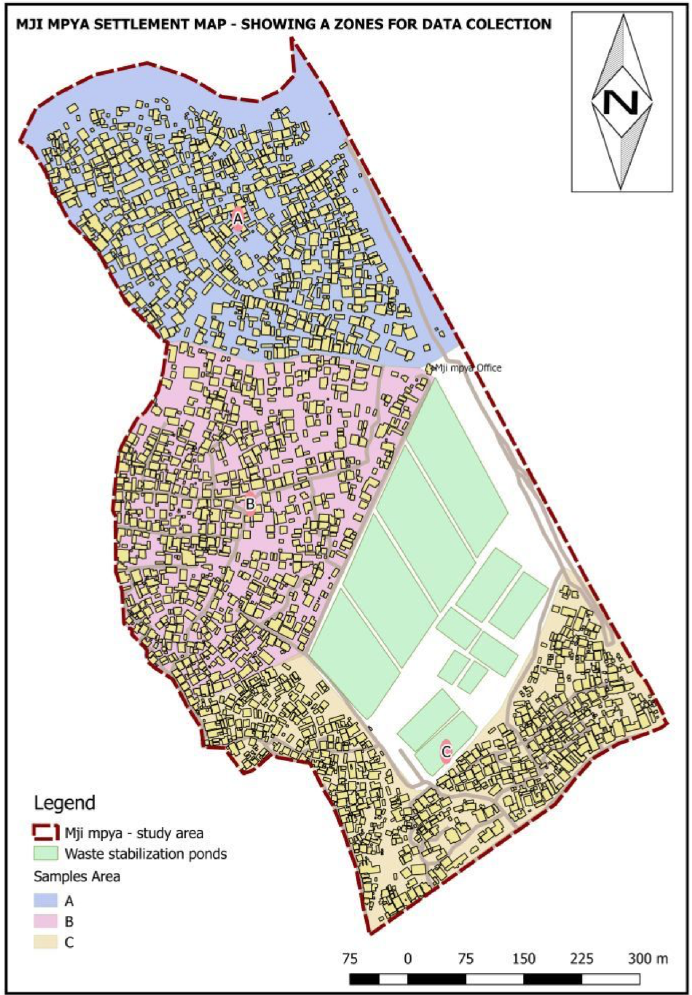
Figure 5. Map of the zonation of Mji Mpya sub-ward: one of three study sites. Based on the unpublished CCI and AXA Project output “Metrics for Policy Action in Urban Areas: Characterising Risks Facing Low-Income Groups” of